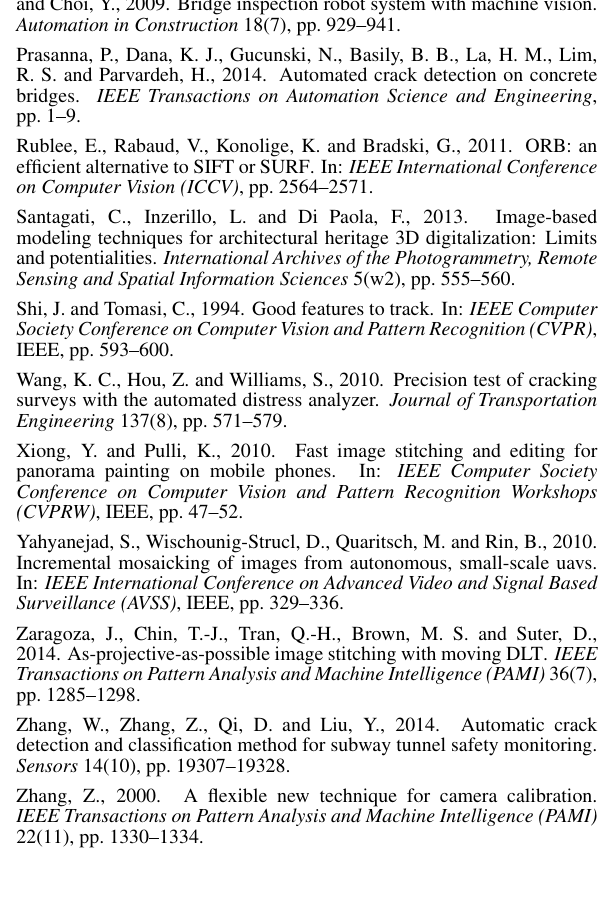
(e) Stitched panorama with the open source software “Enblend” based on the optimized (cid:2)(cid:2)(cid:2) in (c) Figure 10: The stitched panoramas under different conditions. The detailed views of the regions labeled by the red rectangles in these panoramas are correspondingly presented Figure